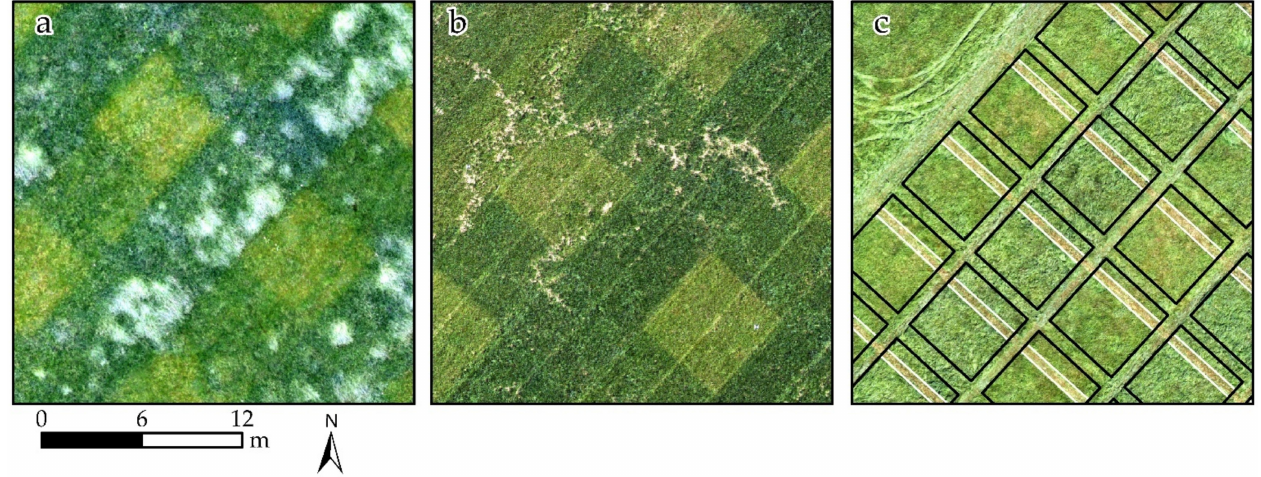
Figure 3. Close-up views of ( a ) bending and lodging canopy (22 May 2019), ( b ) rodent activity (23 July 2019), and ( c ) sampling area (white rectangles) within quadratic plots (3 July 2018).